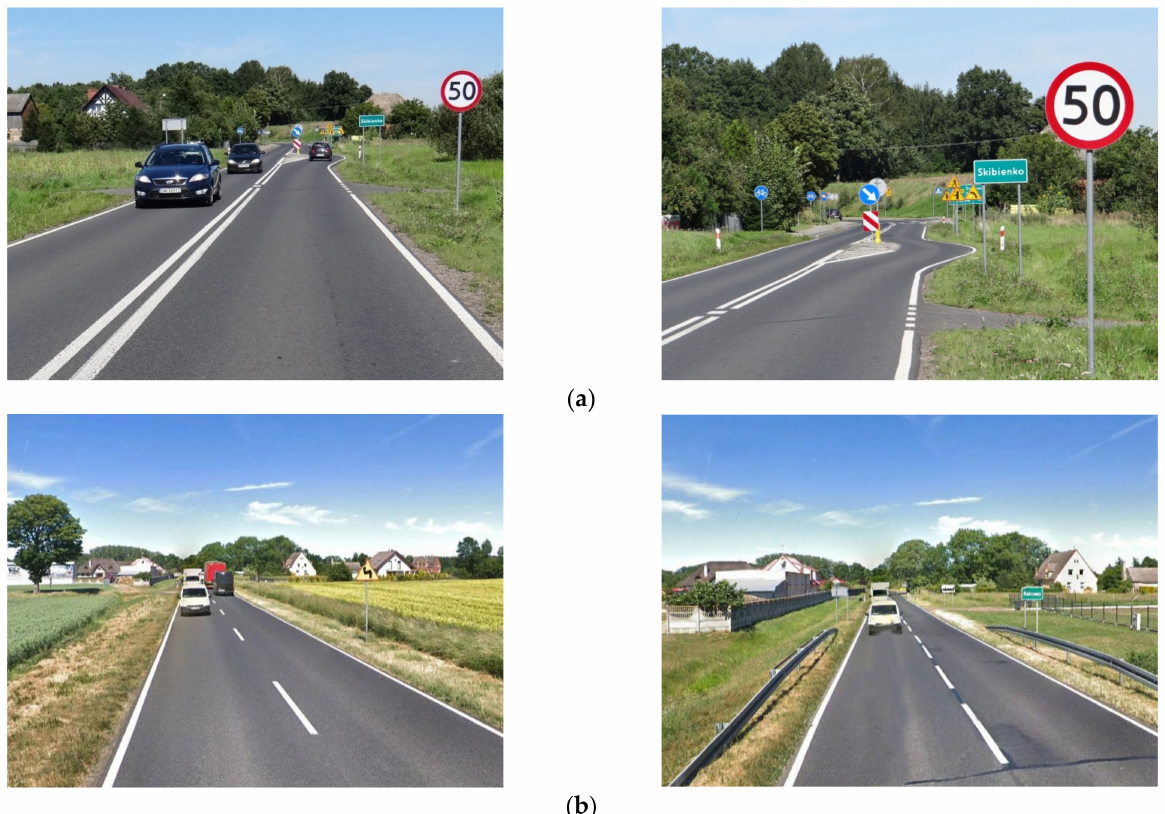
Figure 5. Visibility conditions on the approach to the village ca. 150 m before the chicane or E-17 sign and just at the chicane or the E-17 sign: ( a ) on test section No. 5 with a speed reduction ∆ v 85 = 11.1 km/h; ( b ) on a comparative test section No. 11 with a speed reduction ∆ v 85 = 6.7 km/h without a chicane in place (Source: Google Earth Street View